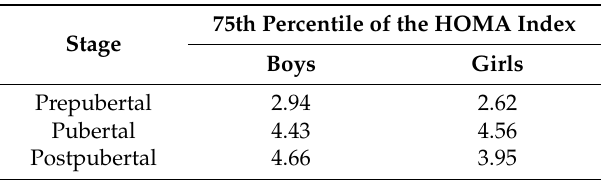
Table 1. Insulin resistance (IR) thresholds assessed using the homeostasis model assessment (HOMA) index by pubertal